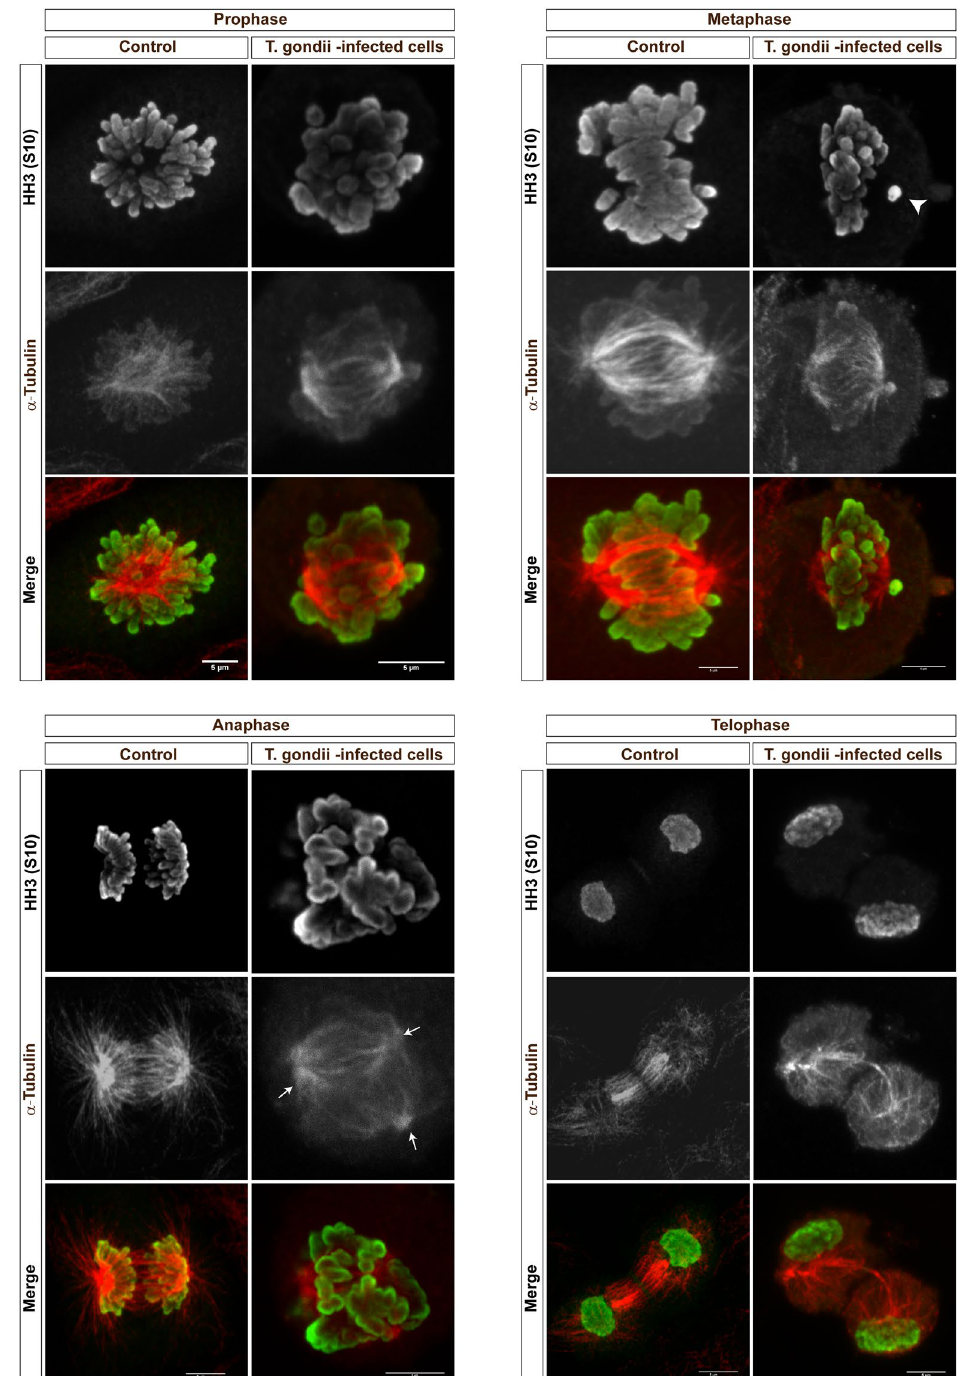
Figure 3. Chromosome segregation of mitotic T. gondii -infected BUVEC. Mitotic T. gondii -infected BUVEC and non-infected cells were stained for chromosomes via phosphor-HH3 S10 (green) and for mitotic spindle via α -Tubulin (red) and analyzed via confocal microscopy. Arrowhead indicates a disalignment of a chromosome (metaphase), white arrows indicate the presence of more than two-spindle poles in anaphase. Scale bar: 5 µ